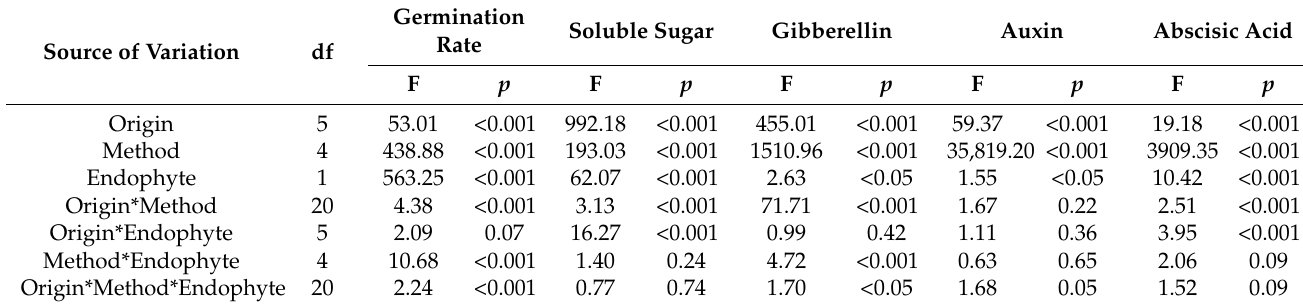
Table 3. Effects of origin, endophyte, dormancy-breaking method, and their interaction on germination and content of soluble sugar, gibberellin, auxin, and abscisic acid in seeds of Achnatherum inebrians . Df = degree of freedom, F = f value is ratio of two means to effect/error term, p = significance.